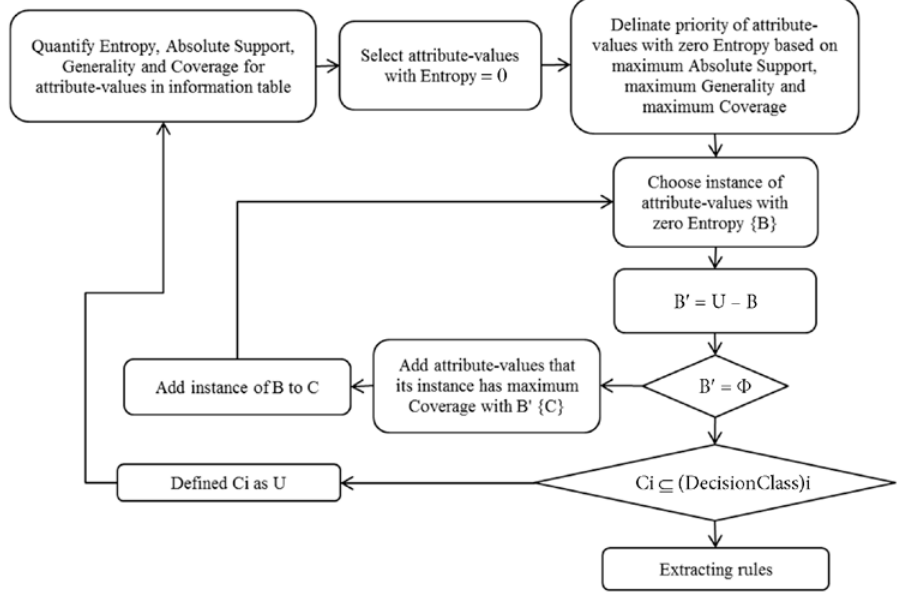
Fig. 1. Granule tree algorithm for mining association